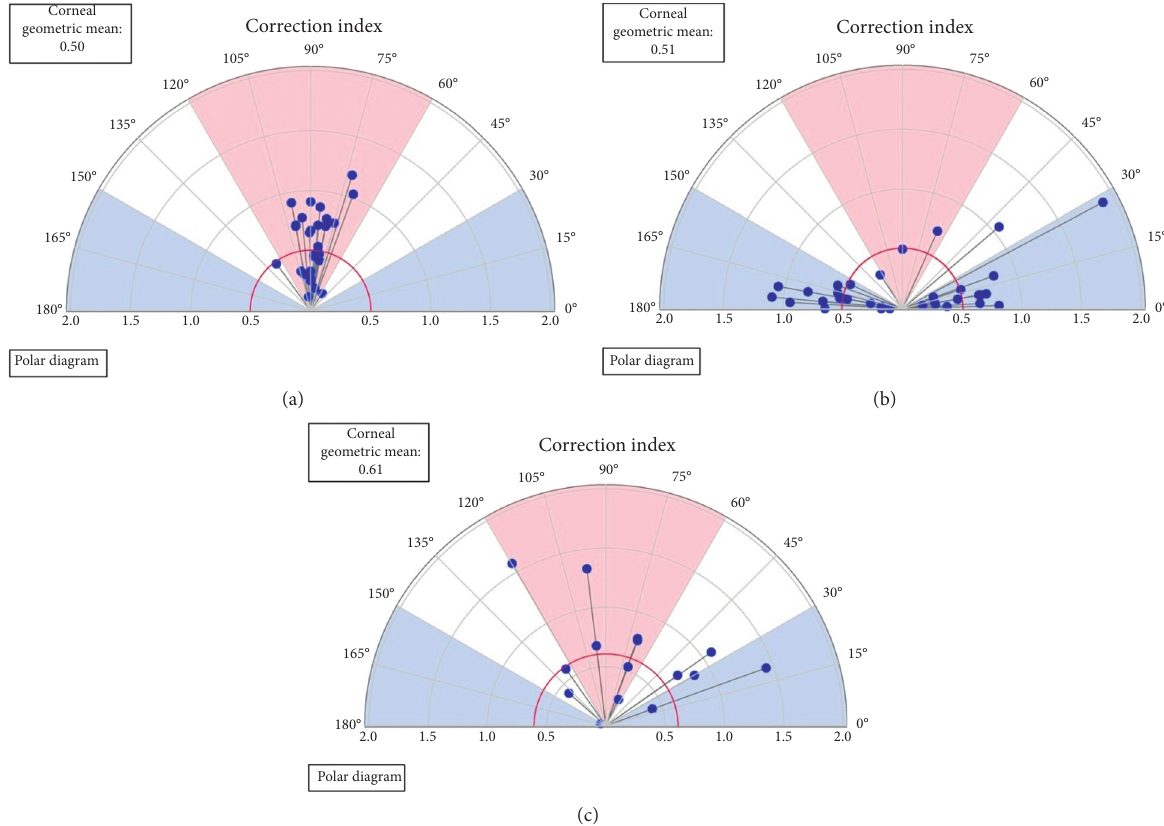
Figure 2: The single angle polar plots displaying the distribution of the correction index according to the astigmatism axis. (a) WTR, with- the-rule astigmatism; (b) ATR, against-the-rule astigmatism; and (c) OBL, oblique